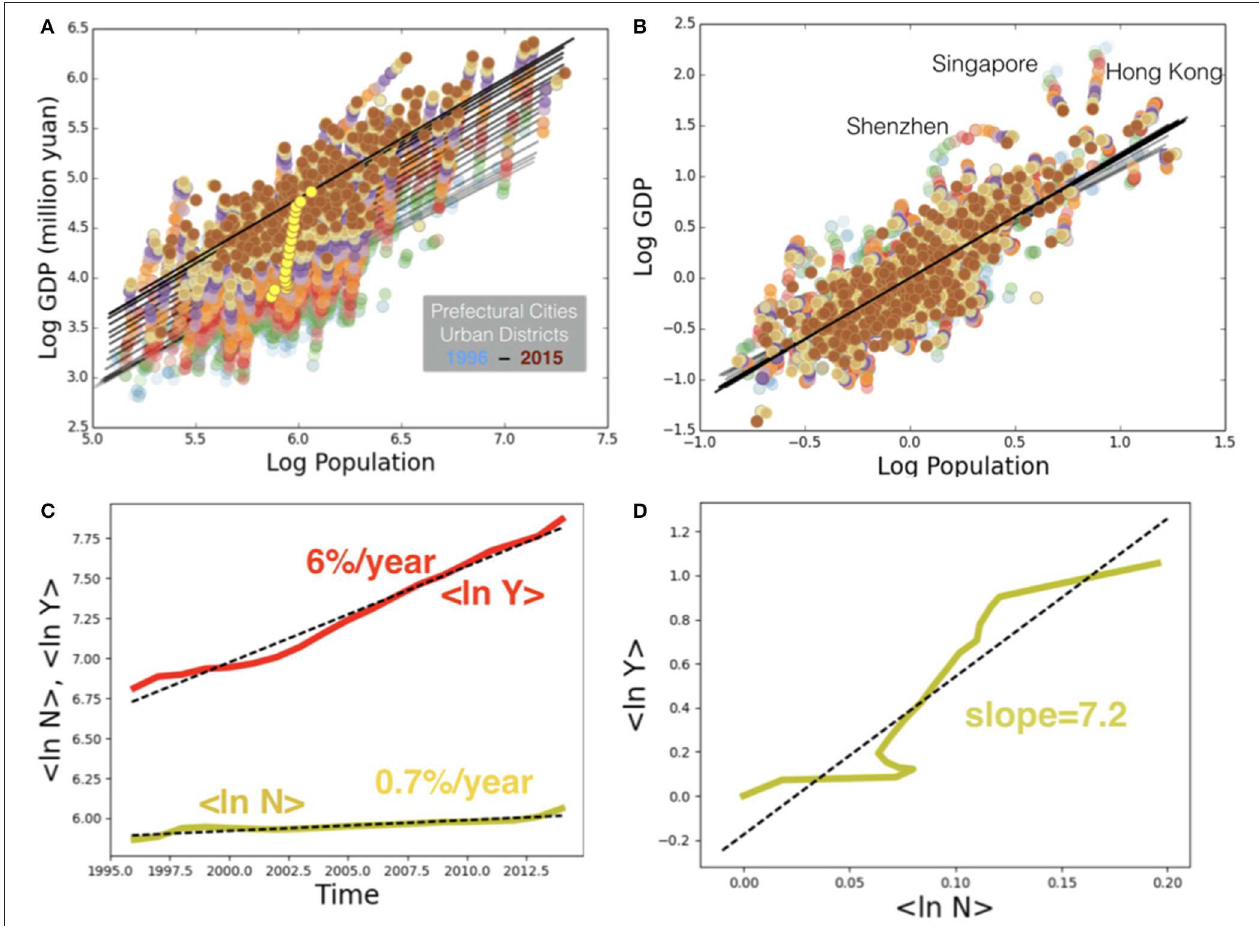
FIGURE 2 | Economic and demographic growth in modern cities, such as those of China (shown) is a property of the urban system. (A) Shows about 20 years of data for Chinese Prefectural cities (colored dots), and the scaling of GDP with population size (solid line shows the scaling relation). (B) Shows the same scaling after system wide growth (yellows squares) is subtracted. This growth is shown in (C) for both GDP (red) and Population (yellow) and versus each other on (D) . Data are from Chinese City Statistical Yearbooks compiled by the Chinese National Bureau of Statistics (see Zünd and Bettencourt, 2019). The same data is compiled